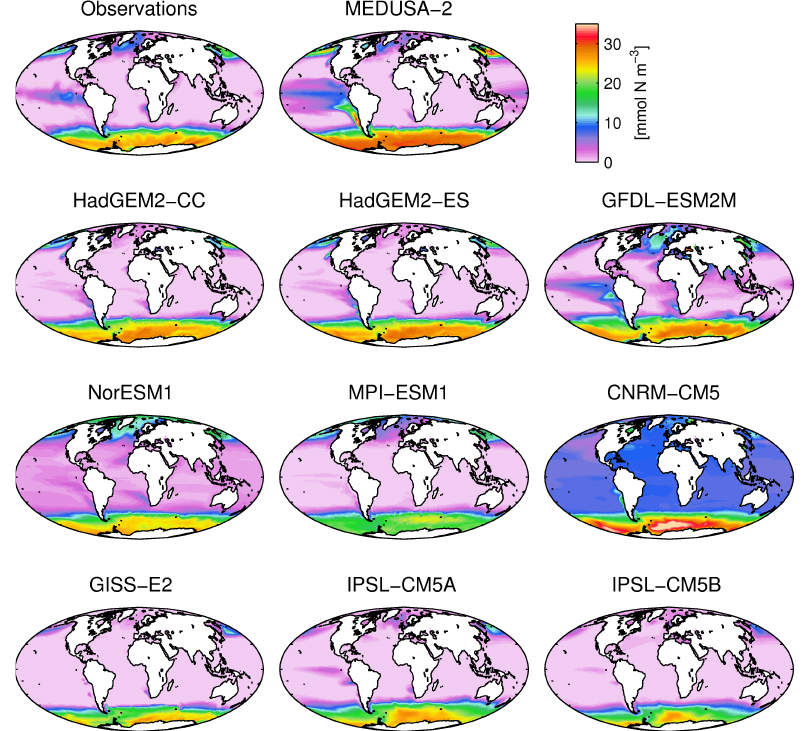
Fig. 42. Intercomparison of annual mean surface dissolved inorganic nitrogen for M EDUSA -2.0 and a range of comparable CMIP5 models. DIN concentration in mmolNm − 3 .